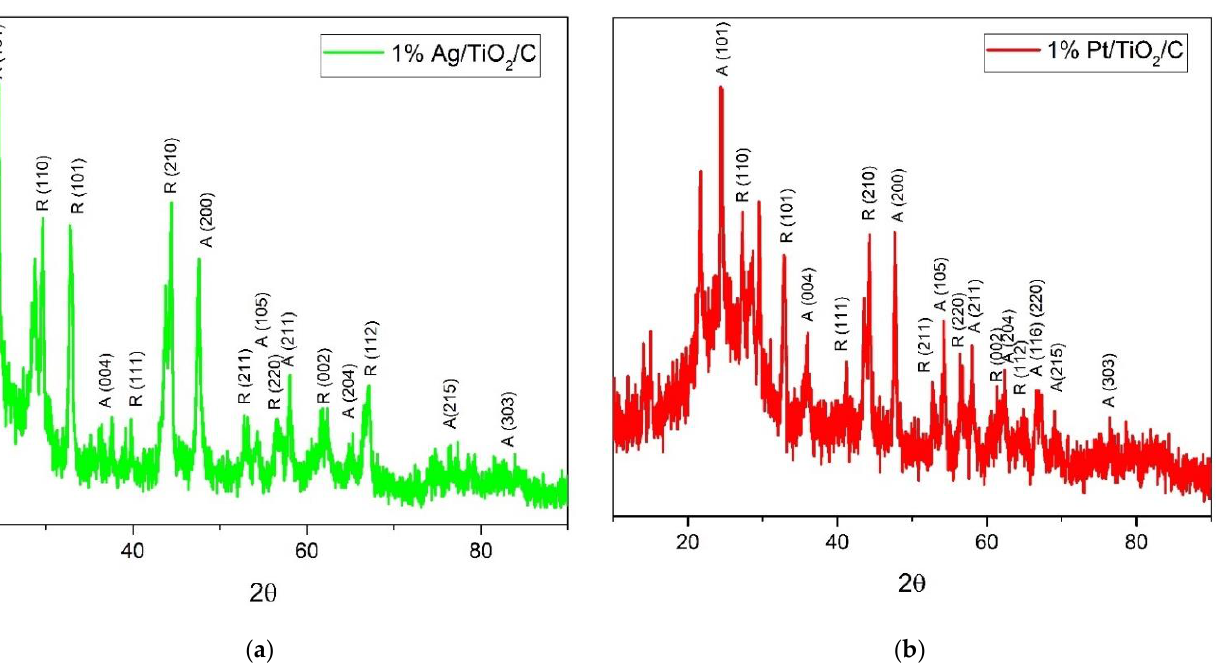
Figure 1. XDR of 1% Ag/TiO 2 /C ( a ) and 1% Pt/TiO 2 /C ( b ). The titanium phases are indicated by A (anatase) and R (rutile).